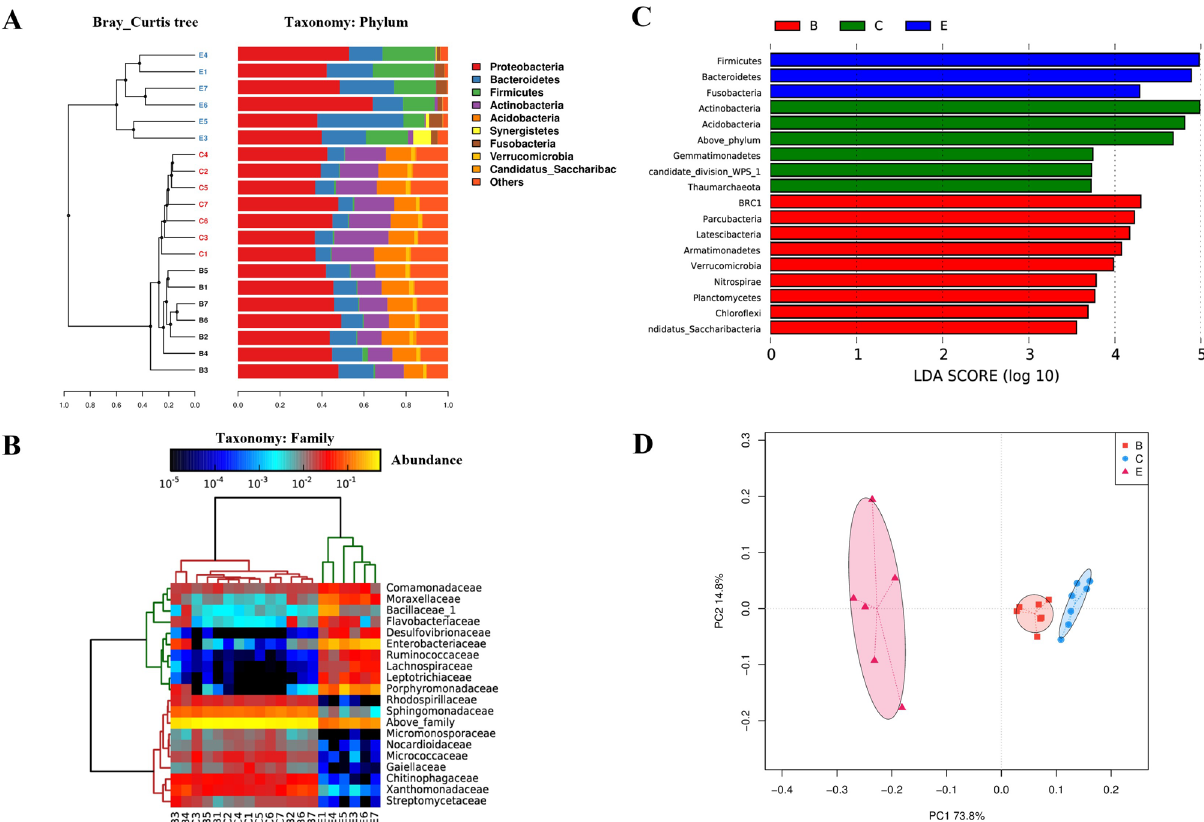
Figure 3. Taxonomic composition of microbial communities in different samples (B: bulk soil, C: SEC and E: egg surface). ( A ) Relative abundance of the microbes at phylum level and ( B ) family level respectively. The sample variation in the community structure is also highlighted in the Bray–Curtis tree ( A ) and cluster tree ( B ). ( C ) Comparison of microbiota using Lefse (LDA) test at the phylum level. LDA scores represent the significant microbial difference among different samples. ( D ) PCA analysis for microbiota variability at the phylum level. Each symbol represents a sample. The variance explained by the PCs is indicated on the